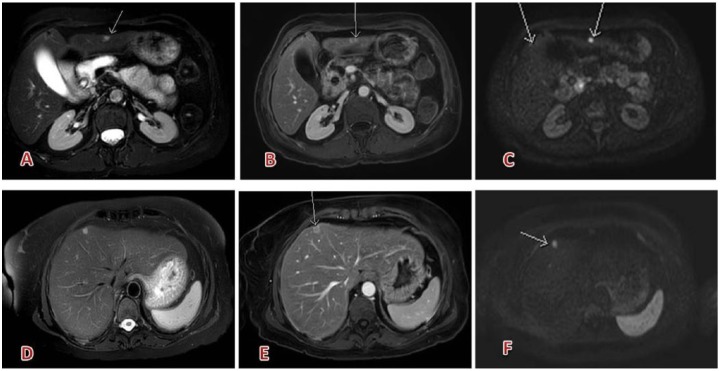
Presence of 2 hepatic metastasis from colon carcinoma: one in the left lobe and the other in the IV segment. These lesions are hyperintense on (A, D) T2; (B, E) early arterial enhancement; (C, F) restricted diffusion. Contrast agent: gadobutrol, 7 mL. Courtesy of Professor De Cobelli, Radiology Department, San Raffaele Scientific Institute, Milan.